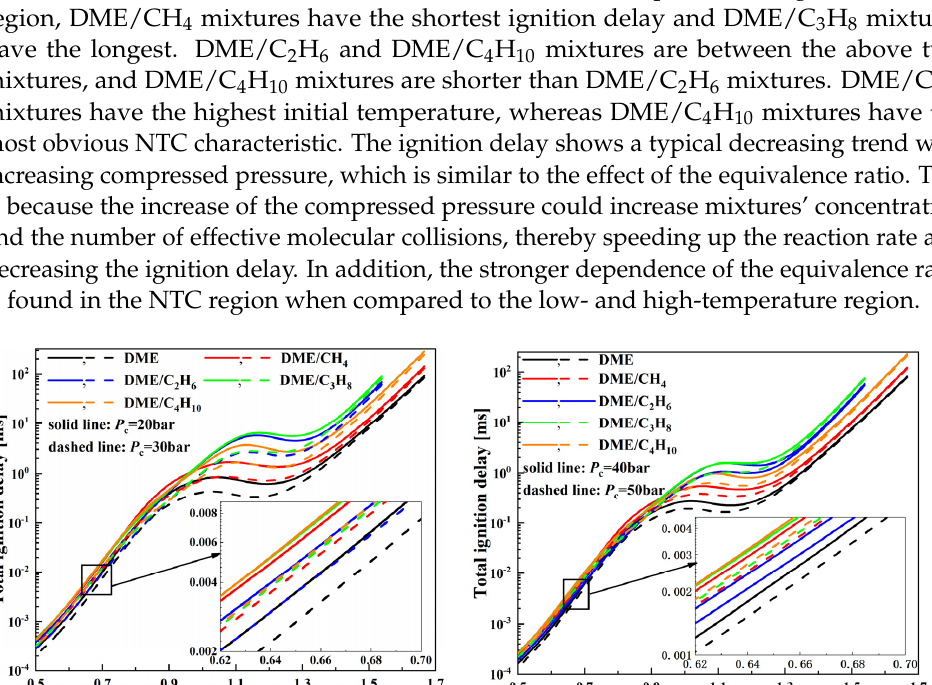
Figure 2. Ignition delay as a function of equivalence ratio for various compressed temperatures at P c = 20 bar: ( a ) T c = 650 K; ( b ) T c = 800 K; and ( c ) T c = 1500 K.